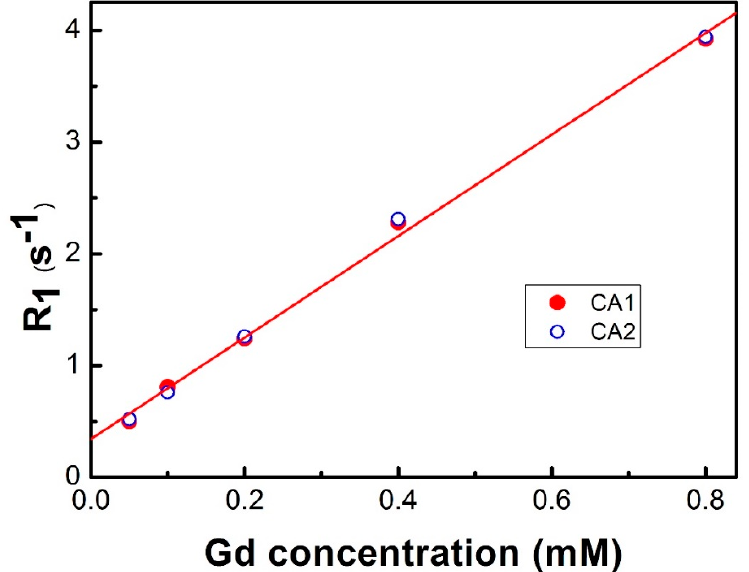
Figure 1. Longitudinal relaxation rate (R 1 ) versus Gd 3+ concentration for CA1 (closed red circles) and CA2 (open blue circles) measured at 60 MHz in a 20 mM 4-(2-hydroxyethyl)-1-piperazineethanesulfonic acid (HEPES) buffer (pH 7.2) at 25 °C. The calibrated T 1 relaxivities (r 1 ) derived from the linear fittings are 4.54 ± 0.13 and 4.58 ± 0.13 mM − 1 s − 1 for CA1 and CA2, respectively.